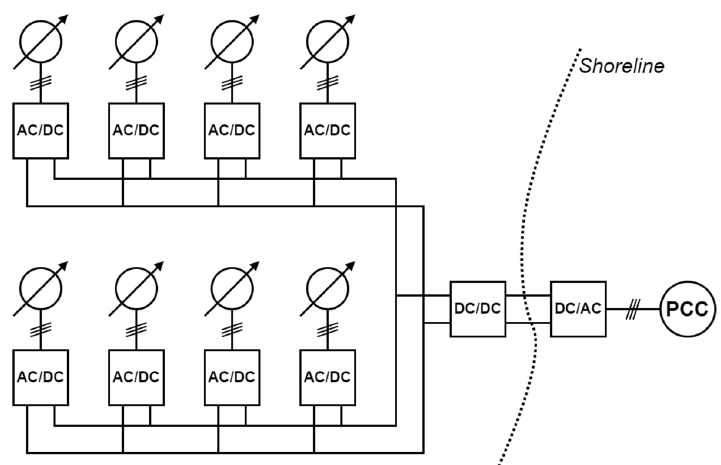
Figure 8. Parallel DC collection grid with an offshore hub.